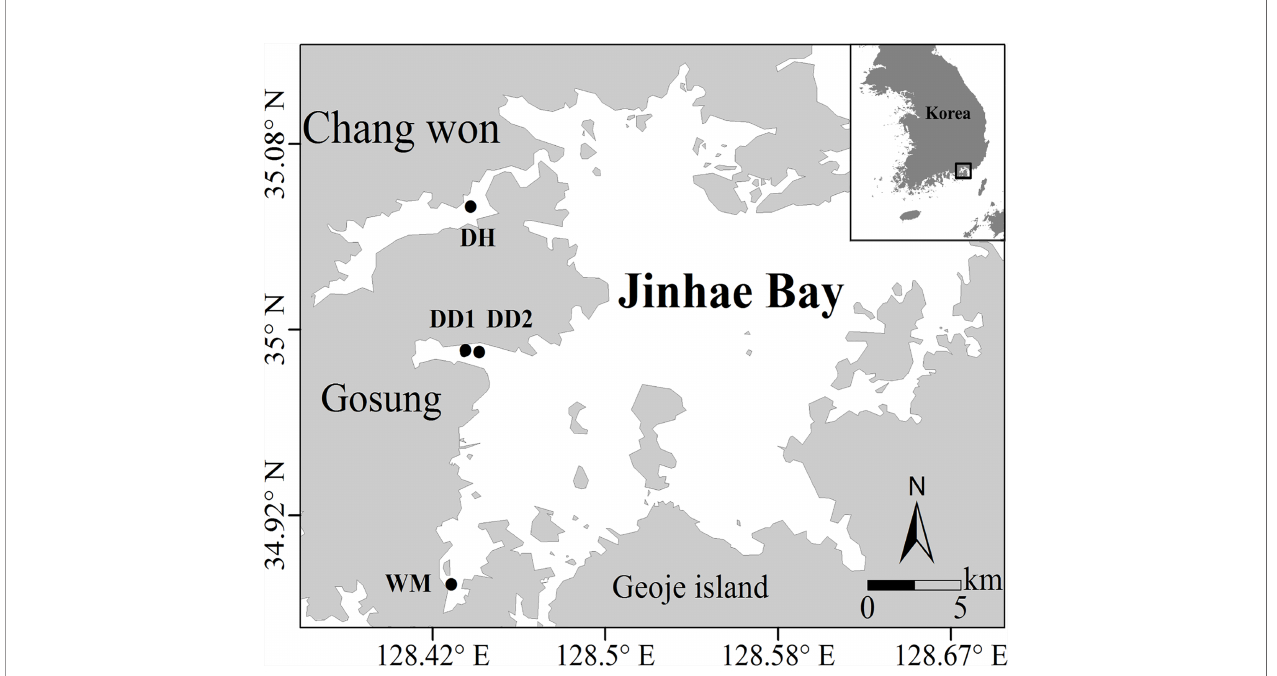
FIGURE 1 | Map of Jinhae Bay showing the location of the four sampling sites: DH, DD1, DD2, and WM, located in Danghang Bay (DH), Dangdong Bay (DD1 and DD2), and Wonmun Bay (WM),